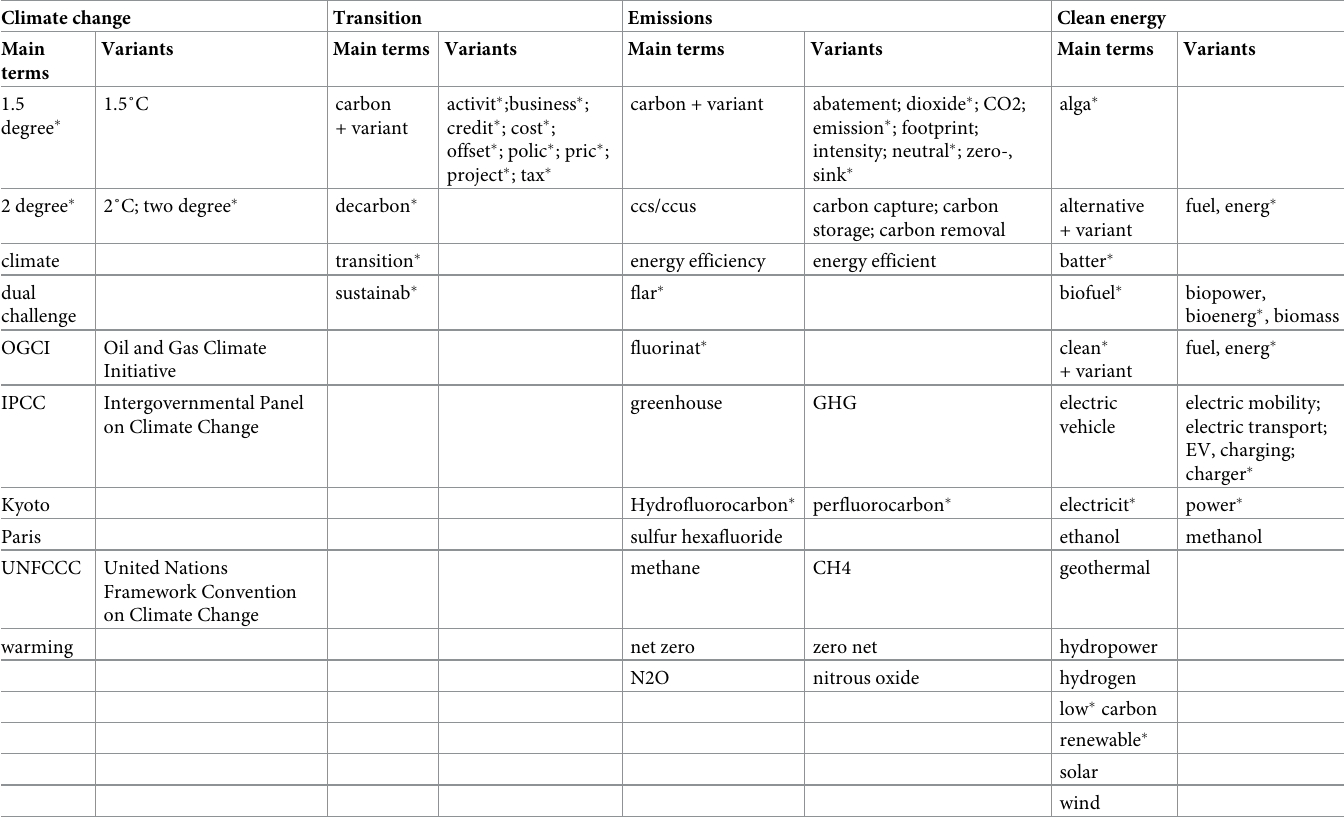
Table 1. Keywords examined in the discourse